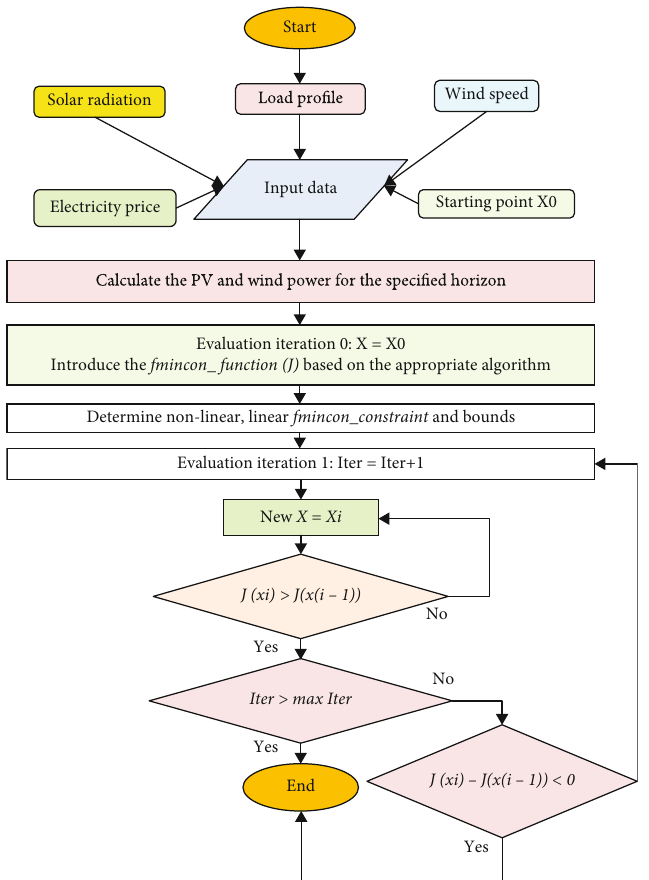
Figure 5: Flow chart of the Fmincon